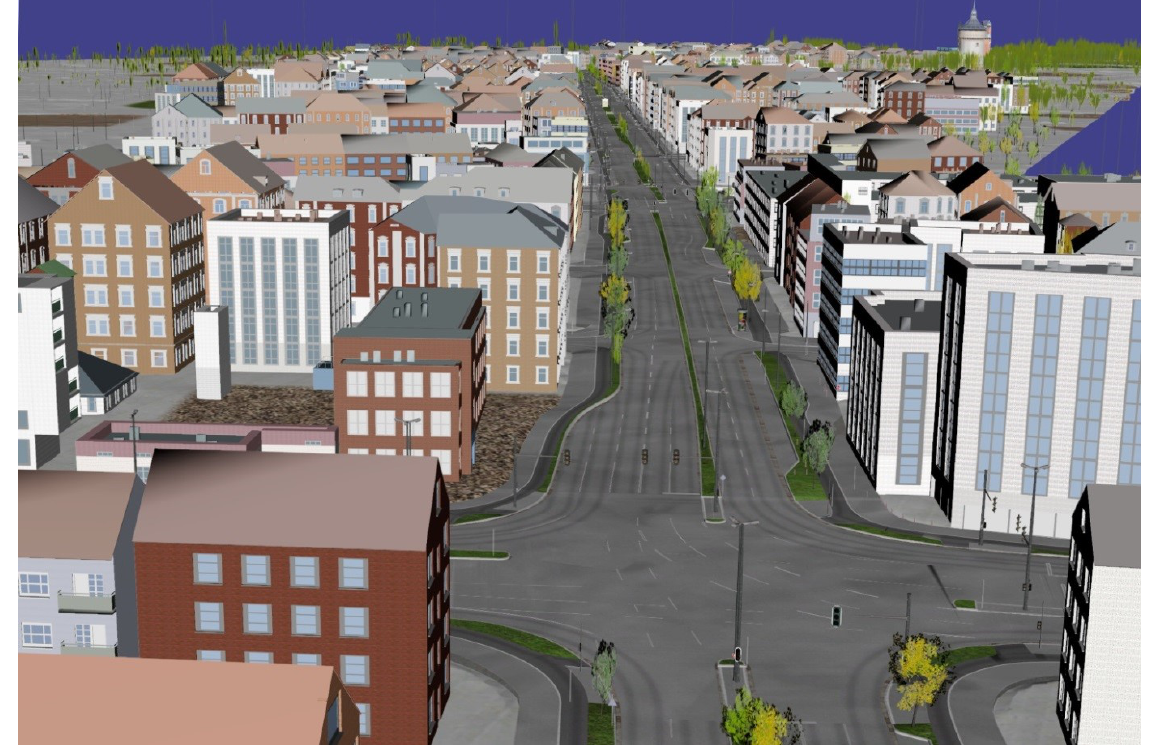
Figure 7: Braunschweiger‘s Hagenring towards the